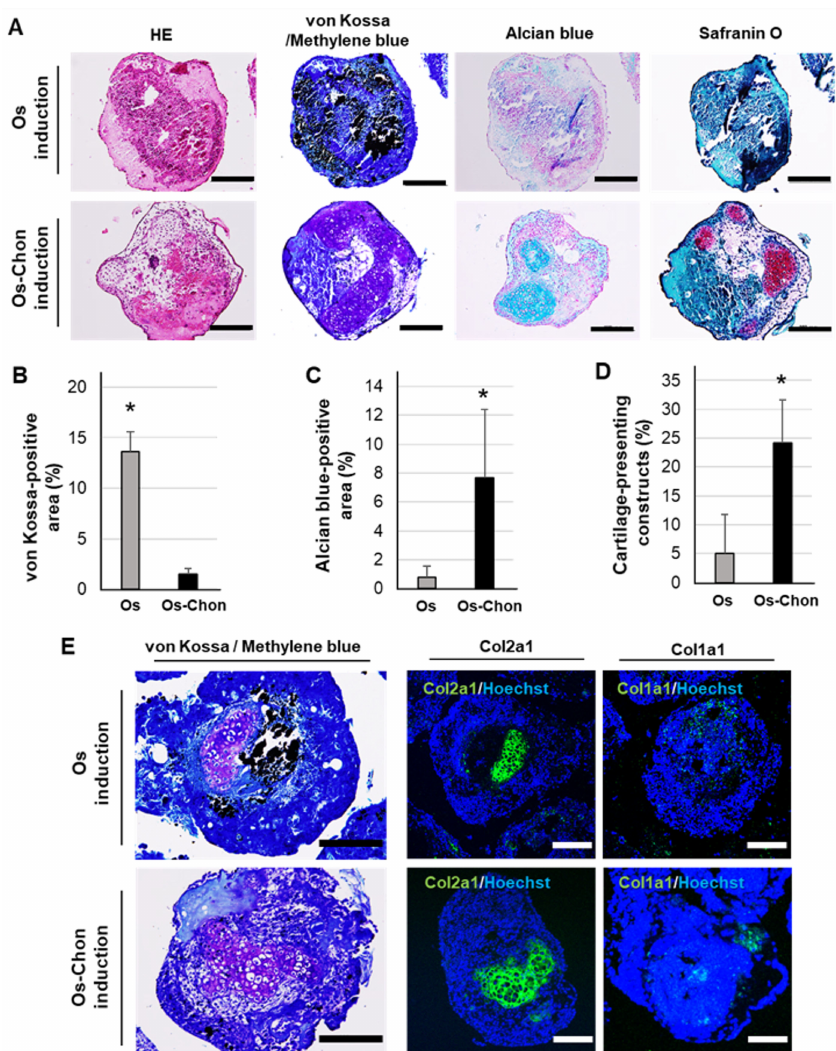
Figure 4. Comparative analysis of bone- and cartilage-like tissue ratio in OI-iPSC and OCI-iPSC constructs at day 43. ( A ) Representative images of histochemical staining by HE, von Kossa (methylene blue-counterstain), alcian blue and safranin O. Scale bars; 200 µ m. Histomorphometric analysis of ( B ) von Kossa-positive areas and ( C ) alcian blue-positive areas, and ( D ) proportion of cartilage-containing constructs in OI-iPSC (Os) and OCI-iPSC (Os-Chon) constructs. The data represent the mean ± SD (B–D; n = 5). Asterisks indicate significant di ff erences between groups ( p < 0.05, Student’s t -test). ( E ) Representative images of methylene blue-counterstained von Kossa staining and immunohistochemical staining with Col2a1 and Col1a1 in OI-iPSC and OCI-iPSC constructs (nuclear counterstain with Hoechst). Scale bars; 200 µ